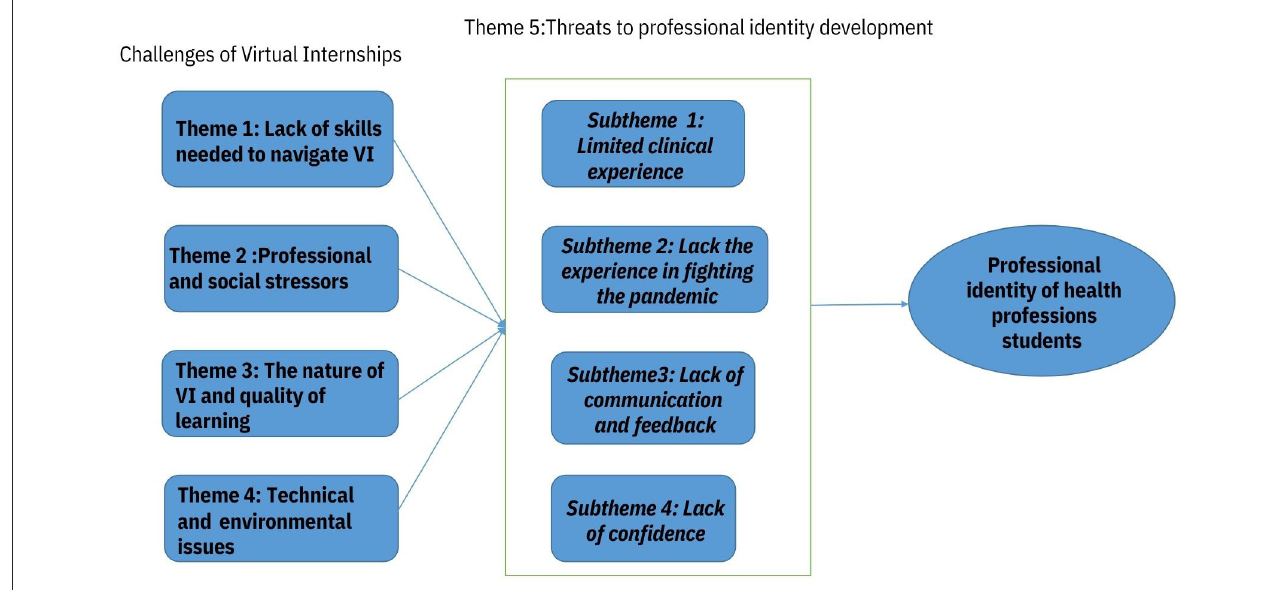
FIGURE1 The themes and sub-themes emerged from the data and their relationship with professional identity.